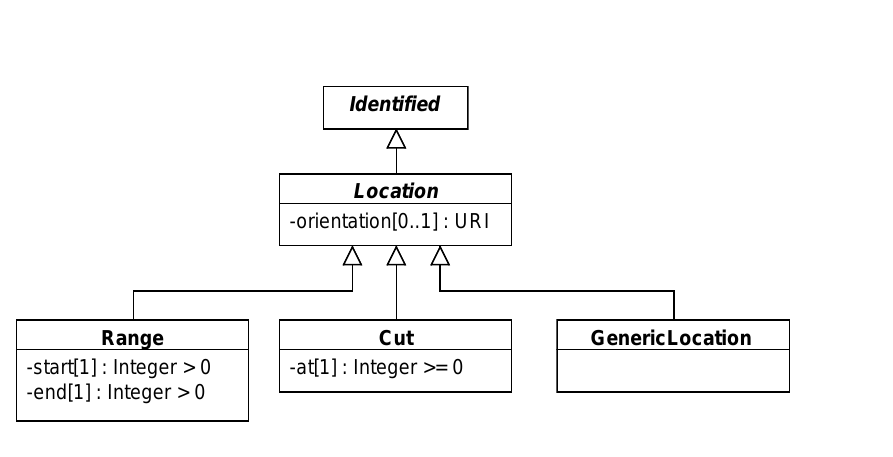
Figure 12: Diagram of the Location class and its associated properties.